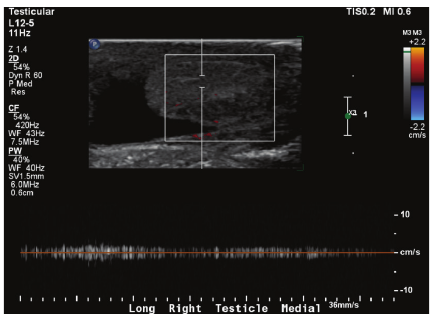
Figure 1: Doppler image of right testis. Normal testicular morphol- ogy was noted and no intratesticular masses were identified. Normal blood flow to the testicle was demonstrated.